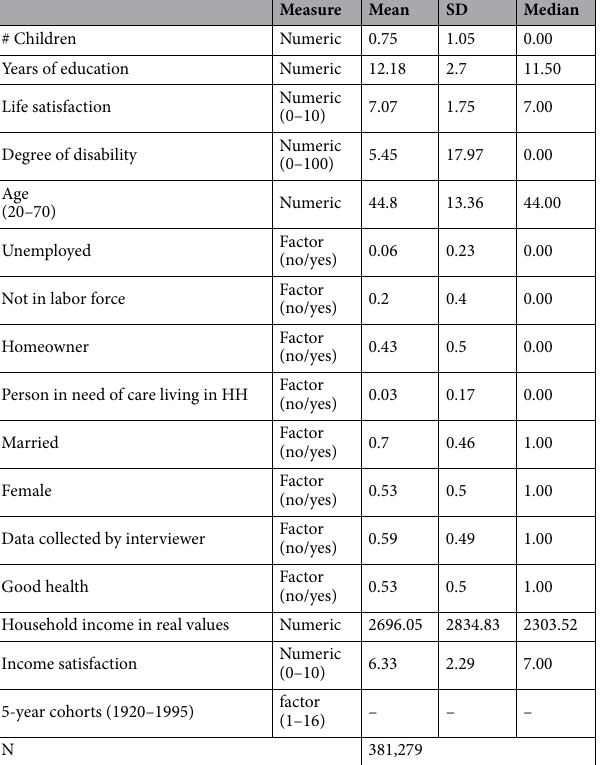
Table 1. Descriptive statistics: